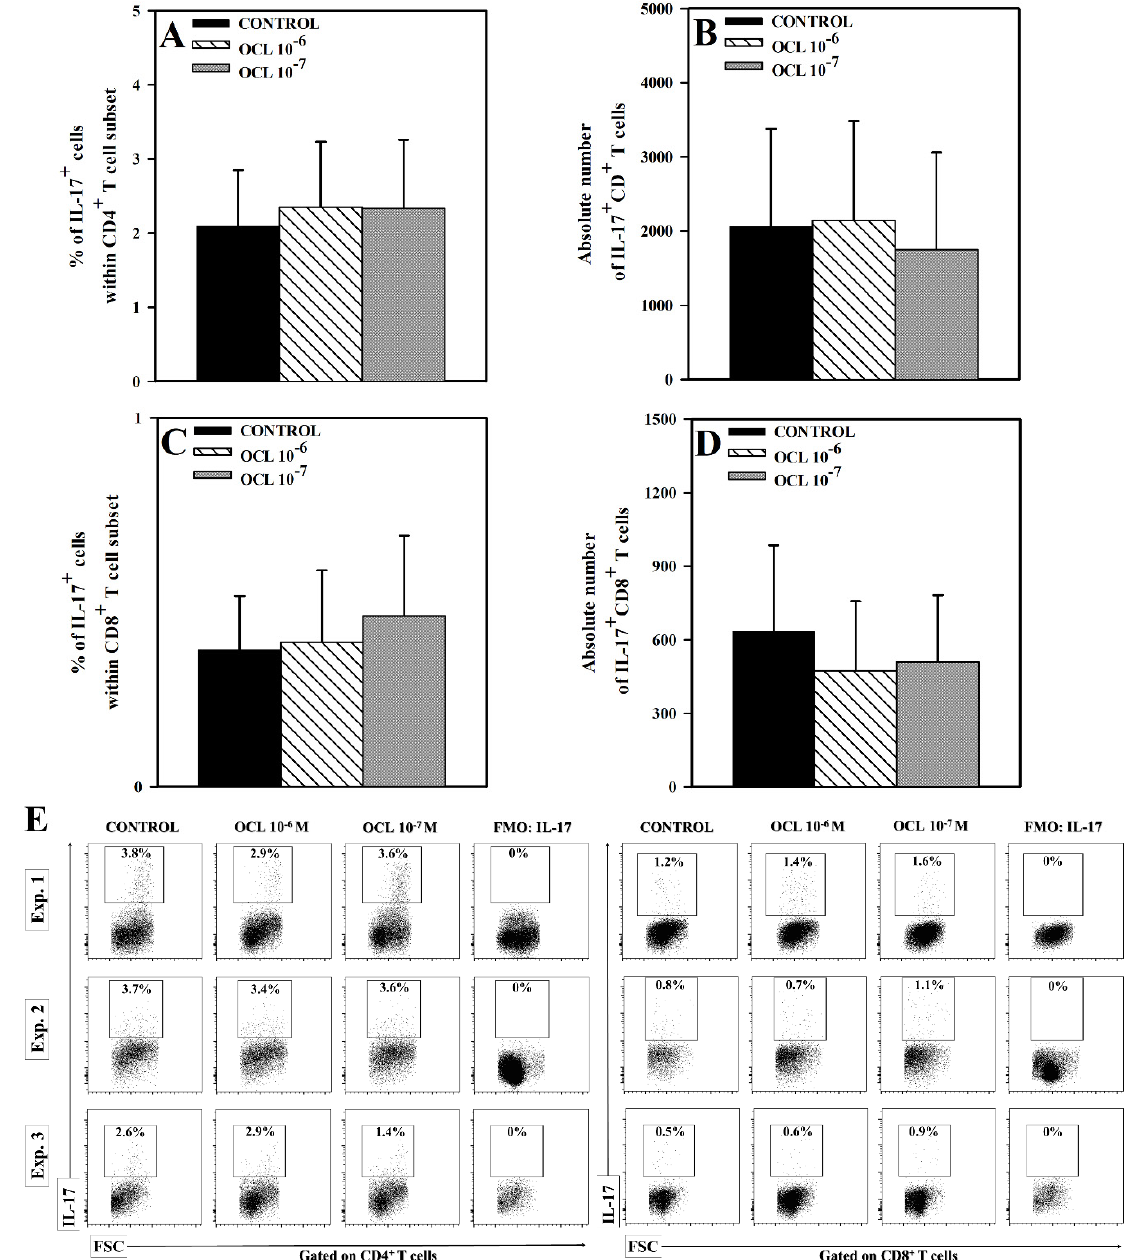
Figure 3. Effect of oclacitinib (OCL) on the number of IL-17-producing CD4 + and CD8 + T cells. The relative ( A , C ) and absolute count ( B , D ) of IL-17-producing CD4 + and CD8 + T cells were determined in cell cultures incubated with or without (control) OCL (10 − 6 M and 10 − 7 M). The relative count is expressed as a percentage of IL-17-producing cells within CD4 + and CD8 + T cells. The absolute count represents the number of IL-17 + CD4 + and IL-17 + CD8 + T cells per sample well. Cells with such phenotypes should be equated with Th17 and Tc17 cells, respectively. Results are expressed as the mean (±S.D.)